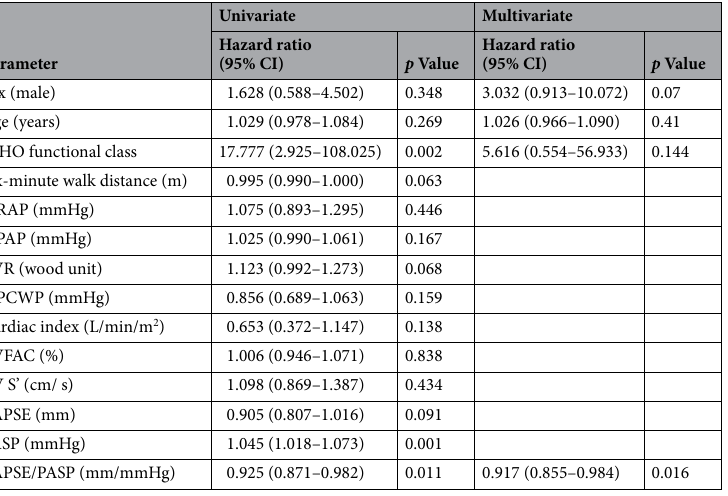
Table 2. Univariate and multivariate Cox proportional analysis of factors associated with LT or death after referral for LT evaluation. CI confidence interval, mPAP mean pulmonary arterial pressure, mPCWP mean pulmonary capillary wedge pressure, mRAP mean right atrial pressure, PASP pulmonary arterial systolic pressure, PVR pulmonary vascular resistance, RVFAC right ventricular fractional area change, RV S’ systolic annular tissue velocity of the lateral tricuspid annulus, TAPSE tricuspid annular plane systolic